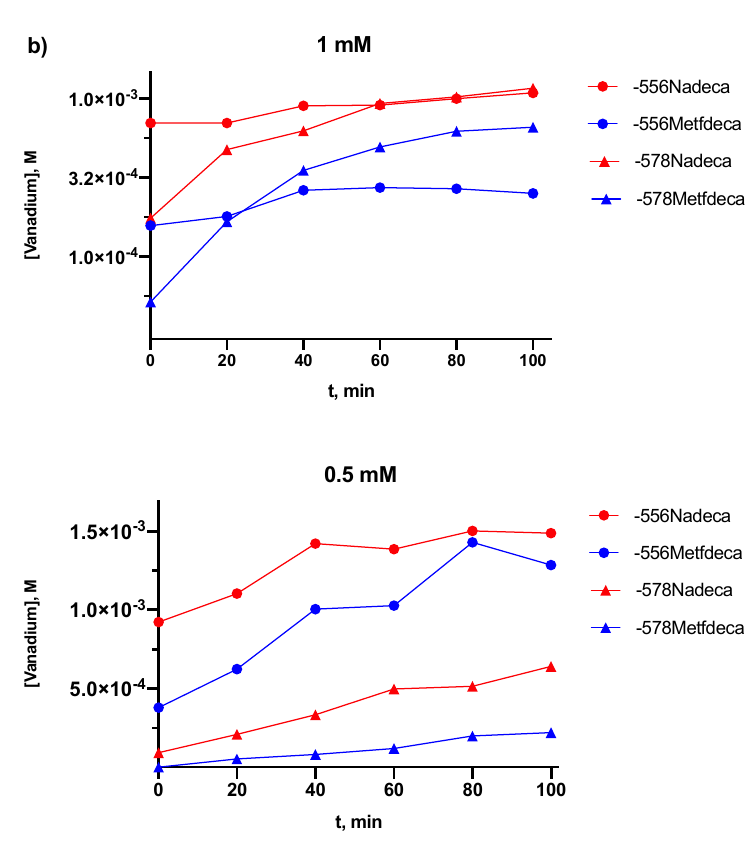
Figure 3. ( a ) 51 V NMR decomposition of 1 mM NaDeca and MetfDeca in Dulbecco’s modified Eagle’s medium (DMEM) medium, plotted as vanadium concentration (10 mM total vanadium concentration) associated with the decameric species V 10A (circle), V 10B (square), V 10C (triangle) over time at 25 °C. ( b ) Hydrolysis of (left) 1 mM and (right) 0.5 mM NaDeca and MetfDeca in DMEM medium followed by the formation of the orthovanadate V 1 at −556 ppm (red circle for NaDeca and blue circle for MetfDeca) and metavanadate species V 4 at −578 ppm (red triangle for NaDeca and blue triangle for MetfDeca) over time at 25 °C.